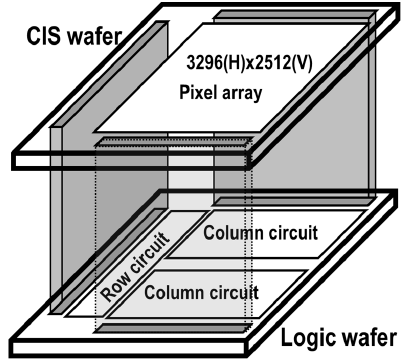
Figure 2. Block diagram of 45 nm stacked CIS test vehicle.